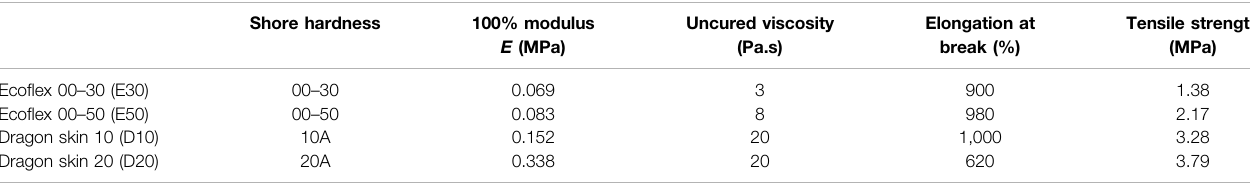
TABLE 2 | Silicone properties. Values from the